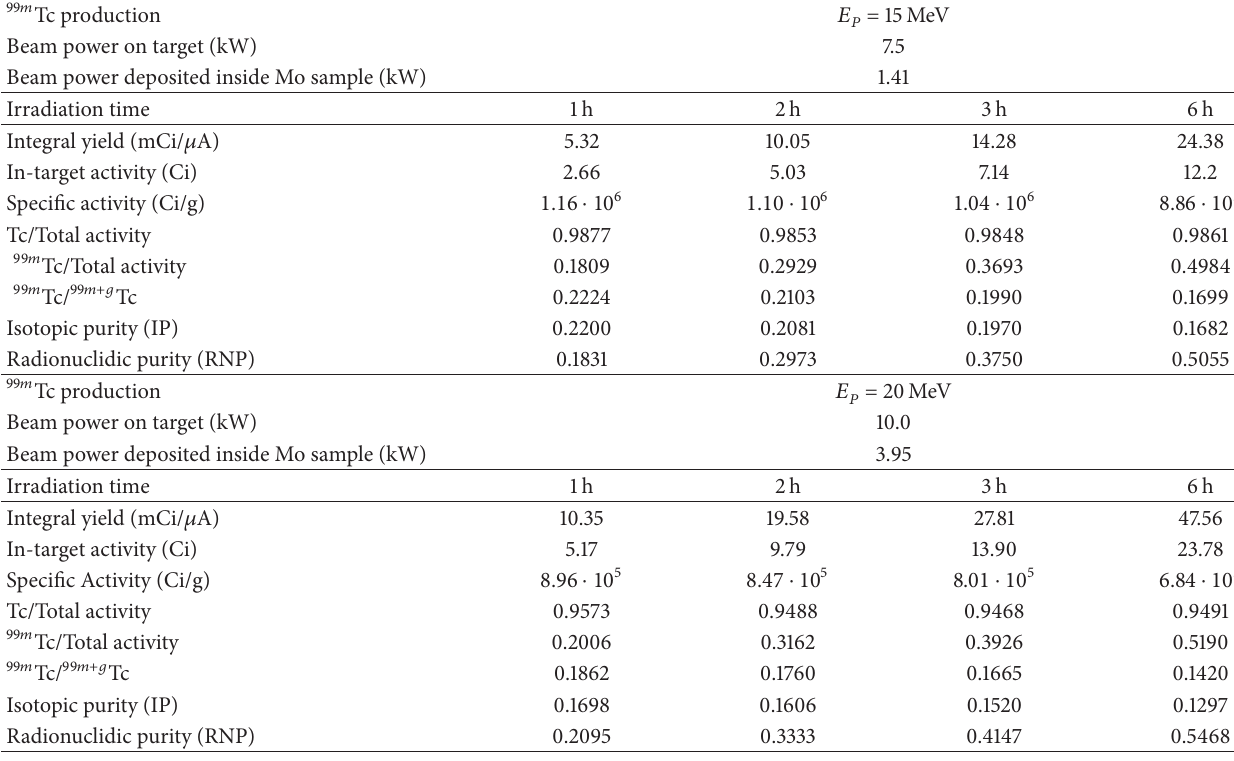
Table 4: The 99𝑚 Tc production yields estimated at EOB for different irradiation times at 15 and 20MeV proton beams on 99.05% 100 Mo- enriched metallic molybdenum and optimized target configuration. 500 𝜇 A proton current and 500 W/cm 2 mean areal power density are considered on target. A series of production quality parameters are calculated and listed (see body